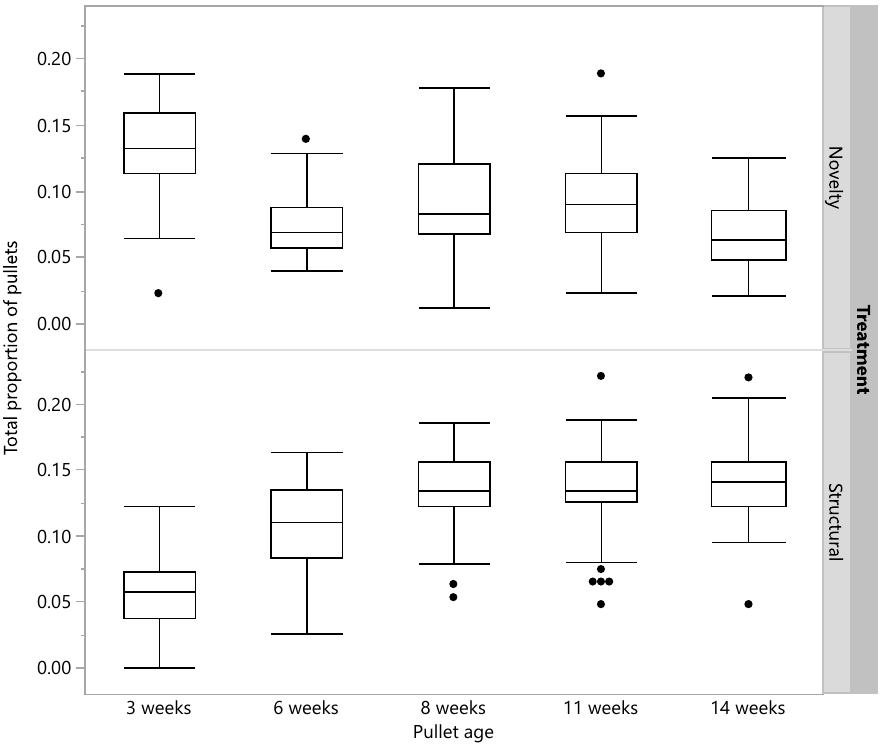
Figure 1. Box plots indicating the proportion of pullets in the pen that were interacting with enrichments in the novelty and structural treatment pens across five age points (3 to 14 weeks of age). The horizontal line within each box indicates the median value with the box ends representing the 1st and 3rd quartiles. The whiskers extend to the outer datapoints that fall within a distance 1.5 × outside the 1st or 3rd quartiles. If datapoints do not reach these computed ranges, the whiskers represent the upper and lower data points (excluding outliers).